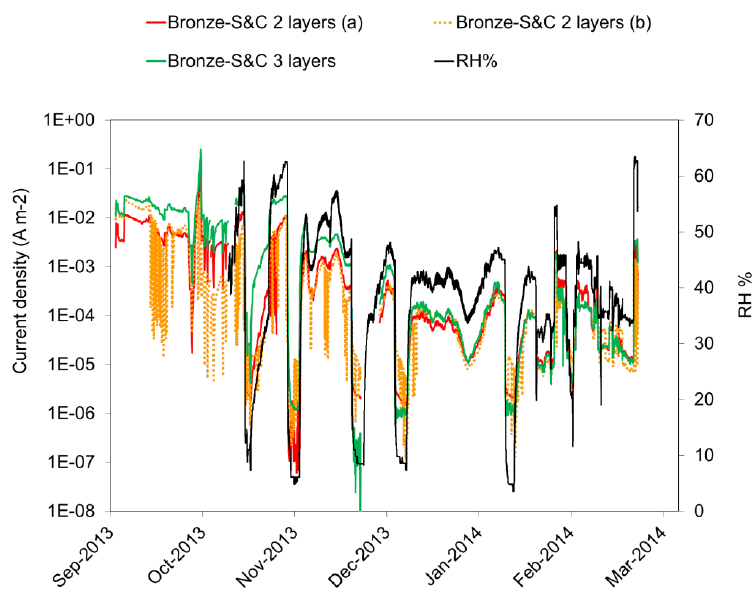
Figure 9. Macrocouple current as a function of time for three galvanic sensors with bronze substrate and double or triple layer of S&C artificial patina.